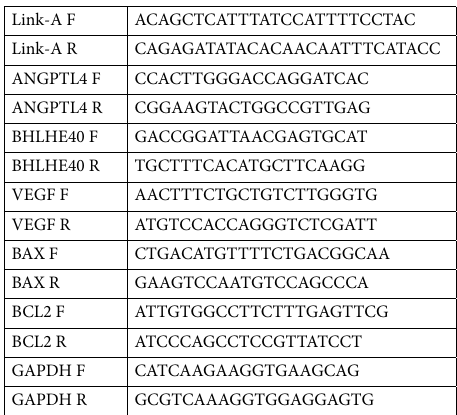
Table 1. Oligonucleotide primers used in real-time